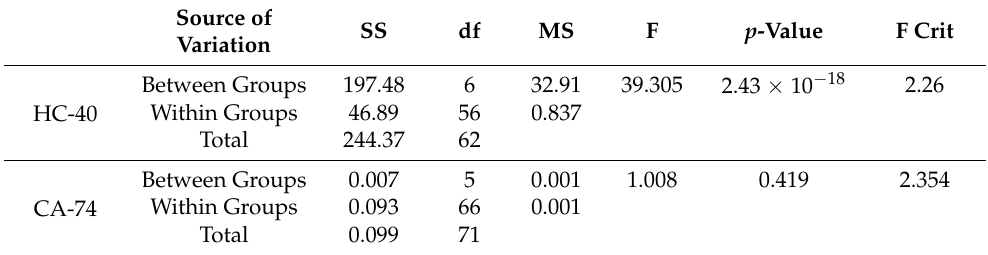
Table 1. Overview of the statistical effects of washing on electrical conductivity.